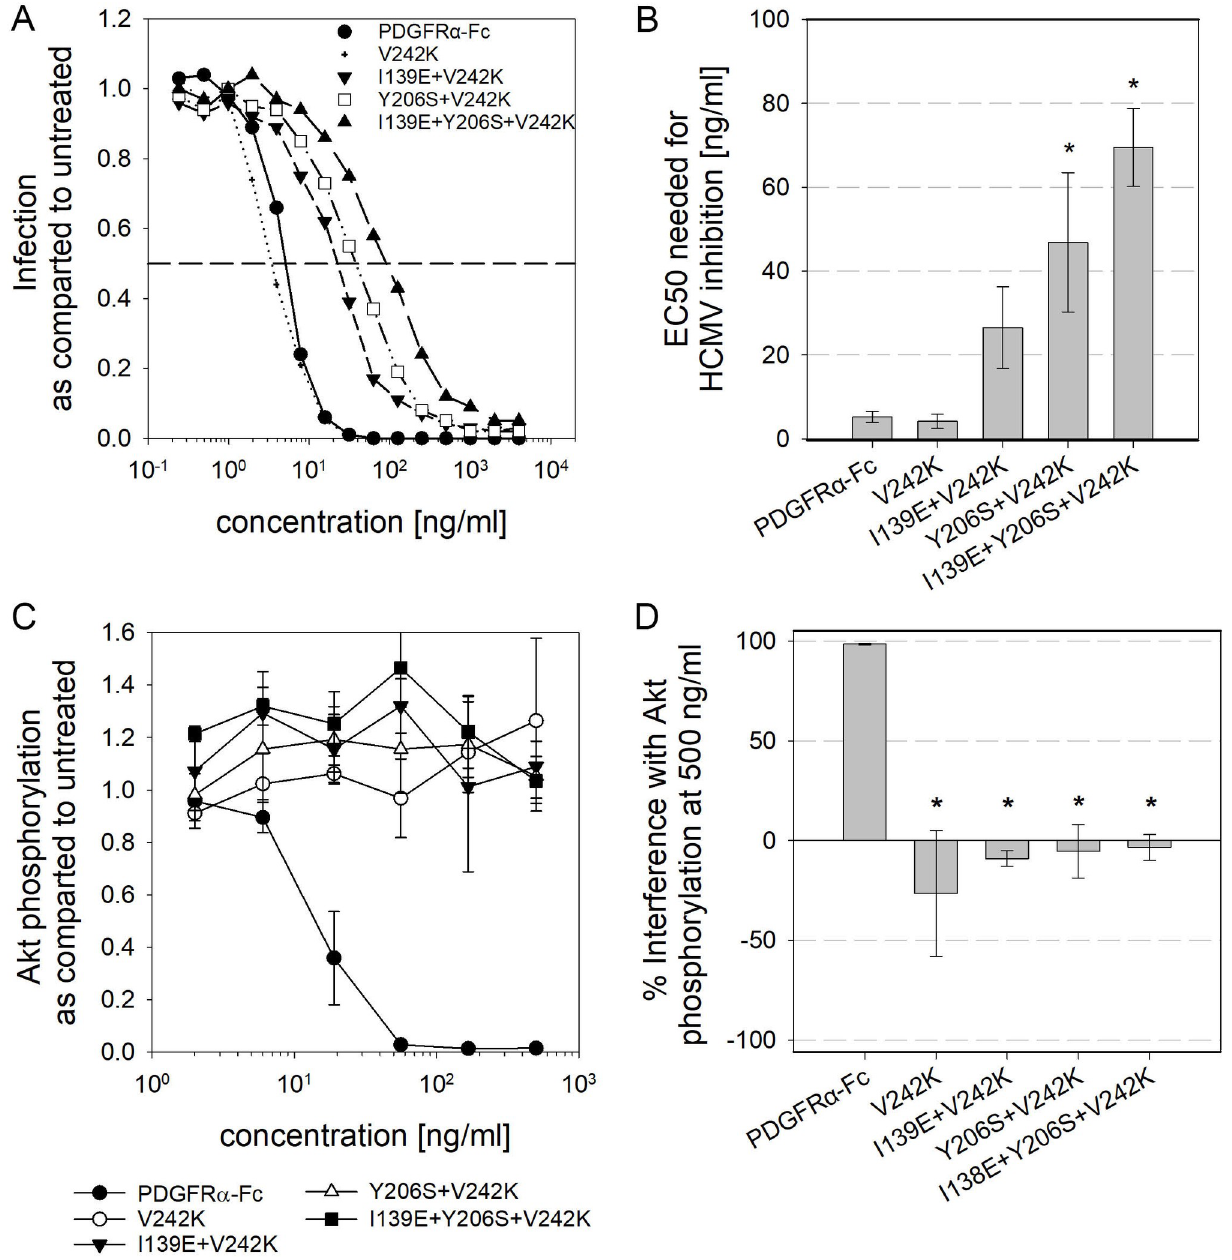
Fig 9. Mutation of V242K abolishes PDGF sequestration without impact on HCMV inhibition. A + B: Quantification of HCMV inhibition by PDGFR α -Fc V242K mutants. To measure the inhibition of infection, the rate of immediate early antigen-positive cells after infection with HCMV untreated or pretreated with PDGFR α -Fc was measured. A shows the average of 3 independent dose-response experiments and B shows the corresponding EC50 values. C + D : PDGF-dependent signaling after preincubation of 6 ng/ml PDGF-BB with various concentrations of PDGFR α -Fc mutants was quantified with a phospho-Akt ELISA. The dose-response curves shown in C depict the mean of 3 independent experiments and D compares the interference of 500 ng/ml of the different PDGFR α -Fcs with PDGF-dependent cellular signaling. 100% interference equals complete inhibition of Akt phosphorylation to the level of unstimulated cells whereas negative values indicate enhanced Akt phosphorylation as compared to cells that were stimulated with untreated PDGF-BB. All error bars indicate standard error of the mean.